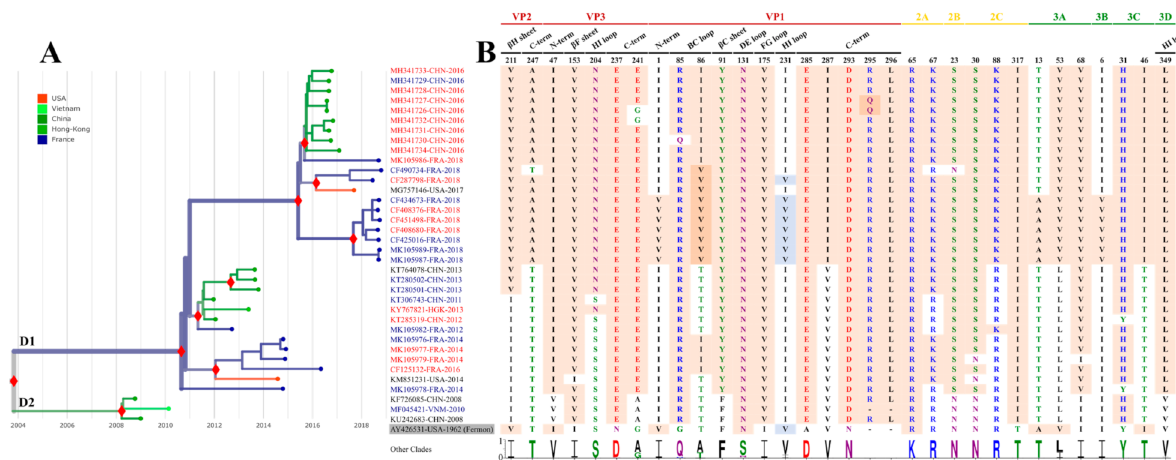
Figure 2. Phylogeny of EV-D68 clade D and molecular variation of viral proteins. ( A ) The phylogenetic tree was obtained with the Nextstrain pipeline using a global dataset of 734 EV-D68 whole genomes available in Genbank (as of 1 February 2020) and 30 new sequences obtained in this study. The solid red diamonds indicate statistical support of main nodes (posterior probability ≥ 0.98). The colours of sequence names match with age groups of related patients: red and blue colours match with adults (>16 years) and children ( ≤ 16 years), respectively. Sequence names in black had no corresponding information on related patient age. The branches are coloured according to the geographic origin. ( B ) Identification of protein positions having amino acid residues specific to clade D. The amino acid positions from other EV-D68 clades are expressed in percentages on the graph with Weblogo 3 [14]. Amino acids with pink background indicate specific positions. Amino acids with blue background match unspecific positions. Amino acids are coloured according to their